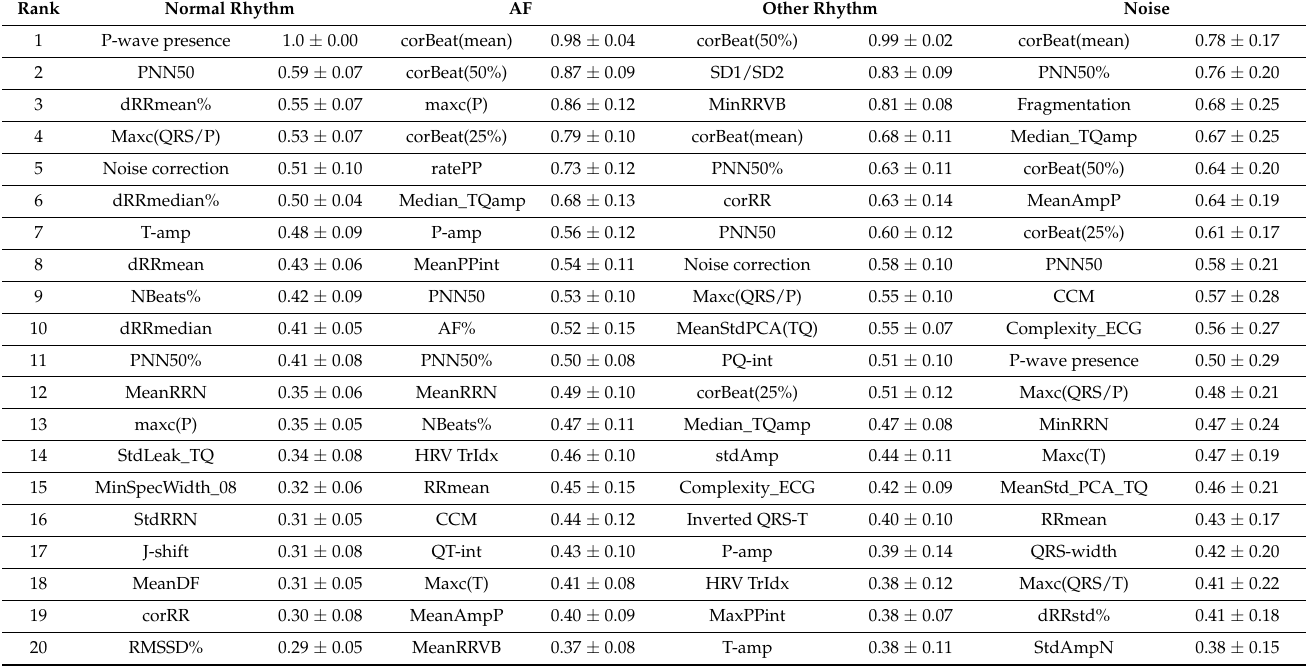
Table 6. Relative Feature Importance of the top-20 features ranked in Figure 8 to maximally contribute for the detection of a specific rhythm class, reported as mean absolute value ± standard deviation computed over 20 × 5-fold independent runs of DenseNet-3@128-32-4